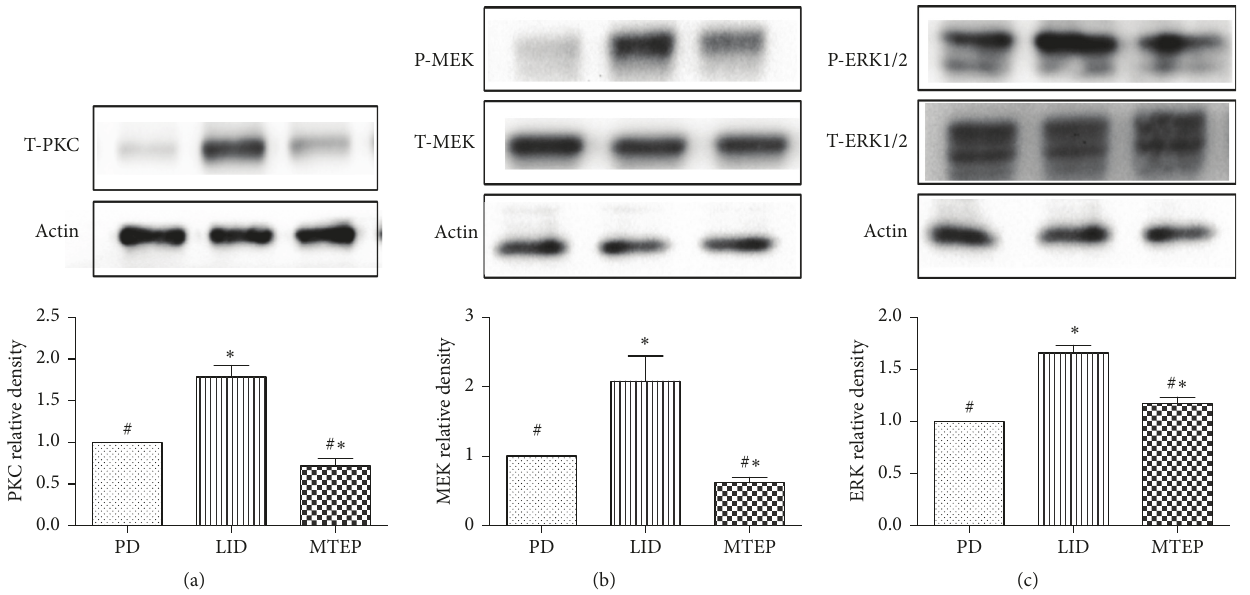
Figure 4: (a–c) Protein levels were evaluated by western blotting of samples from the lesioned side of the striatum (% of PD). (a) Protein level of PKC expressed relative to the level of 𝛽 -actin in the 6-OHDA-lesioned rats treated with saline, L-Dopa (25mg/kg) plus benserazide (6.25/kg), and MTEP. (b) Protein level of p-MEK level expressed relative to the total MEK level in the 6-OHDA-lesioned rats treated with saline, L-Dopa (25mg/kg) plus benserazide (6.25/kg), and MTEP expressed relative to the level of 𝛽 -actin in the sample. (c) p-ERK1/2 level expressed relative to the total ERK1/2 level in the 6-OHDA-lesioned rats treated with vehicle, L-Dopa (25mg/kg) plus benserazide (6.25/kg), andMTEPexpressedrelativetothelevelof 𝛽 -actininthesample.ComparisonswiththeLIDgrouprevealedthatMTEPpreventedtheincrease of PKC, p-MEK, and p-ERK1/2 after chronic L-Dopa treatment ( # 𝑝 < 0.05 ). Comparisons with the PD group revealed that PKC, p-MEK, and p-ERK levels were increased in the LID group, but there is a minor decrease in the PKC and MEK expression level ( ∗ 𝑝 < 0.05 ); there is no significant difference in the p-ERK1/2 expression level. The data represent the mean relative optical density ± SD (one-way ANOVA, 𝑛 = 4 per group).